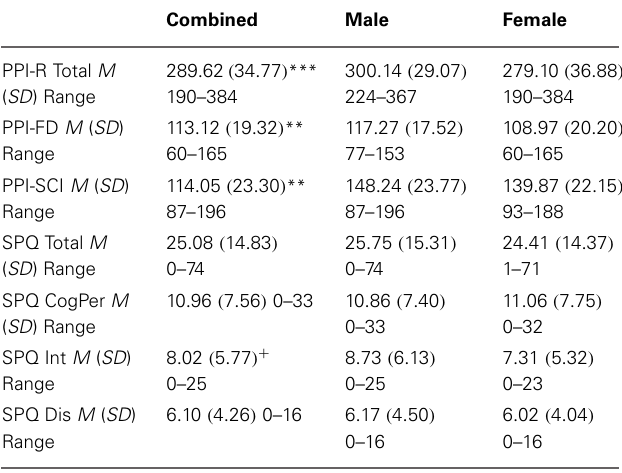
Table 1 | SPQ and PPI-R descriptive statistics.